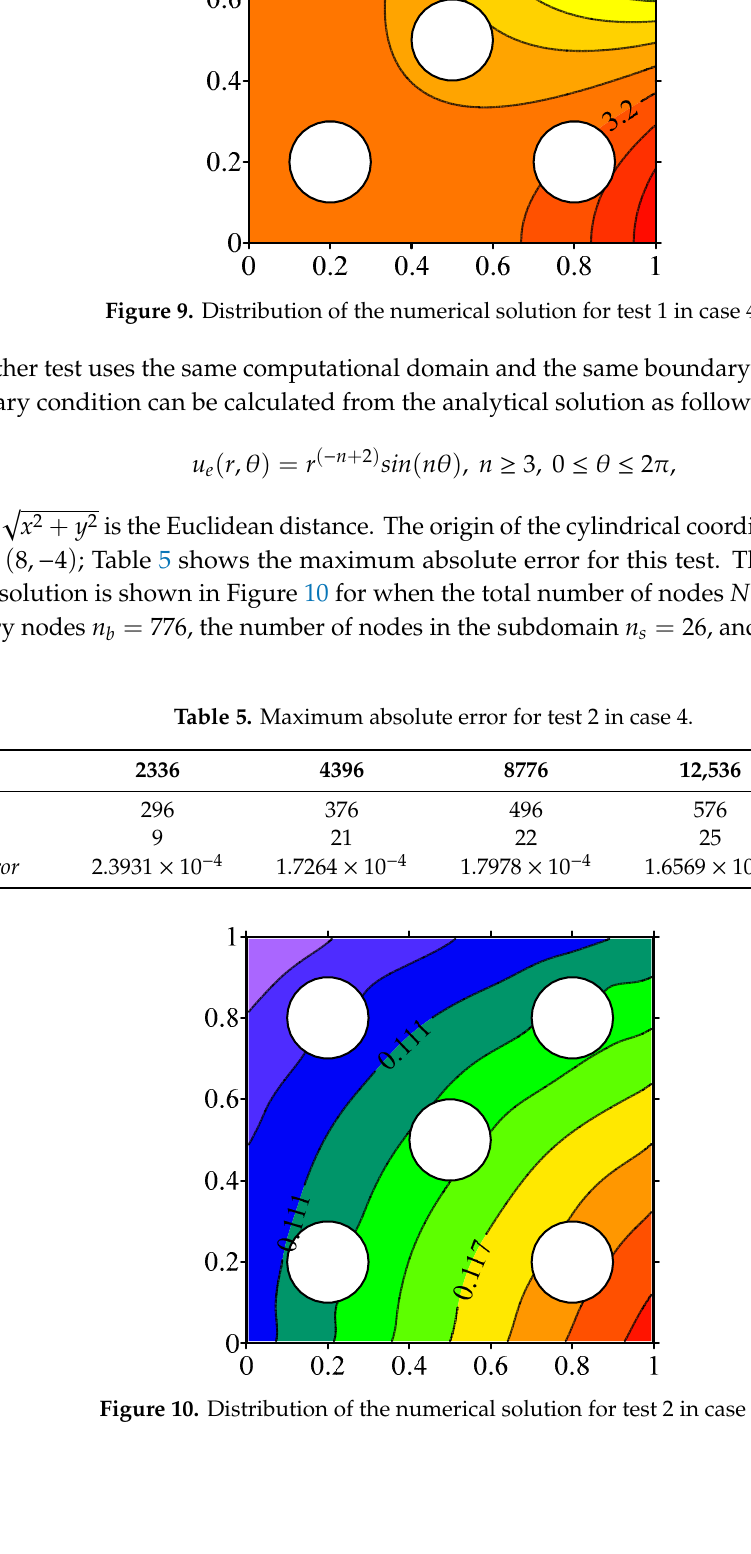
Table 4. Maximum absolute error for test 1 in case 4.